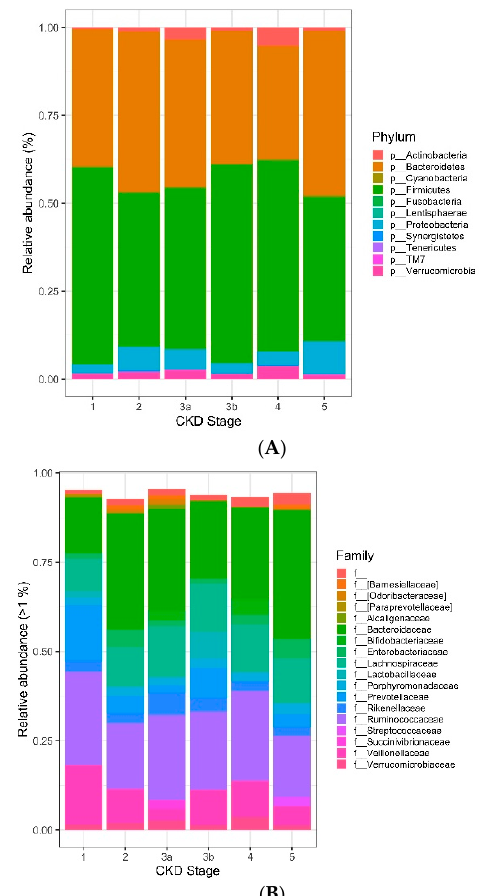
Figure 4. ( A ). Stacked bar charts display the average relative abundance of bacterial operational taxonomic units (OTUs) identified to the taxonomic level of phylum in the gut microbiome of individuals with different stages of CKD disease. Abundances were calculated from trimmed data to remove OTUs that were prevalent in <2 samples with <2 counts in the complete dataset. ( B ). Stacked bar charts display the average relative abundance of bacterial operational taxonomic units (OTUs) identified to the taxonomic level of family in the gut microbiome of individuals with different stages of CKD disease. Abundances were calculated from trimmed data to remove OTUs that were prevalent in <2 samples with <2 counts in the complete